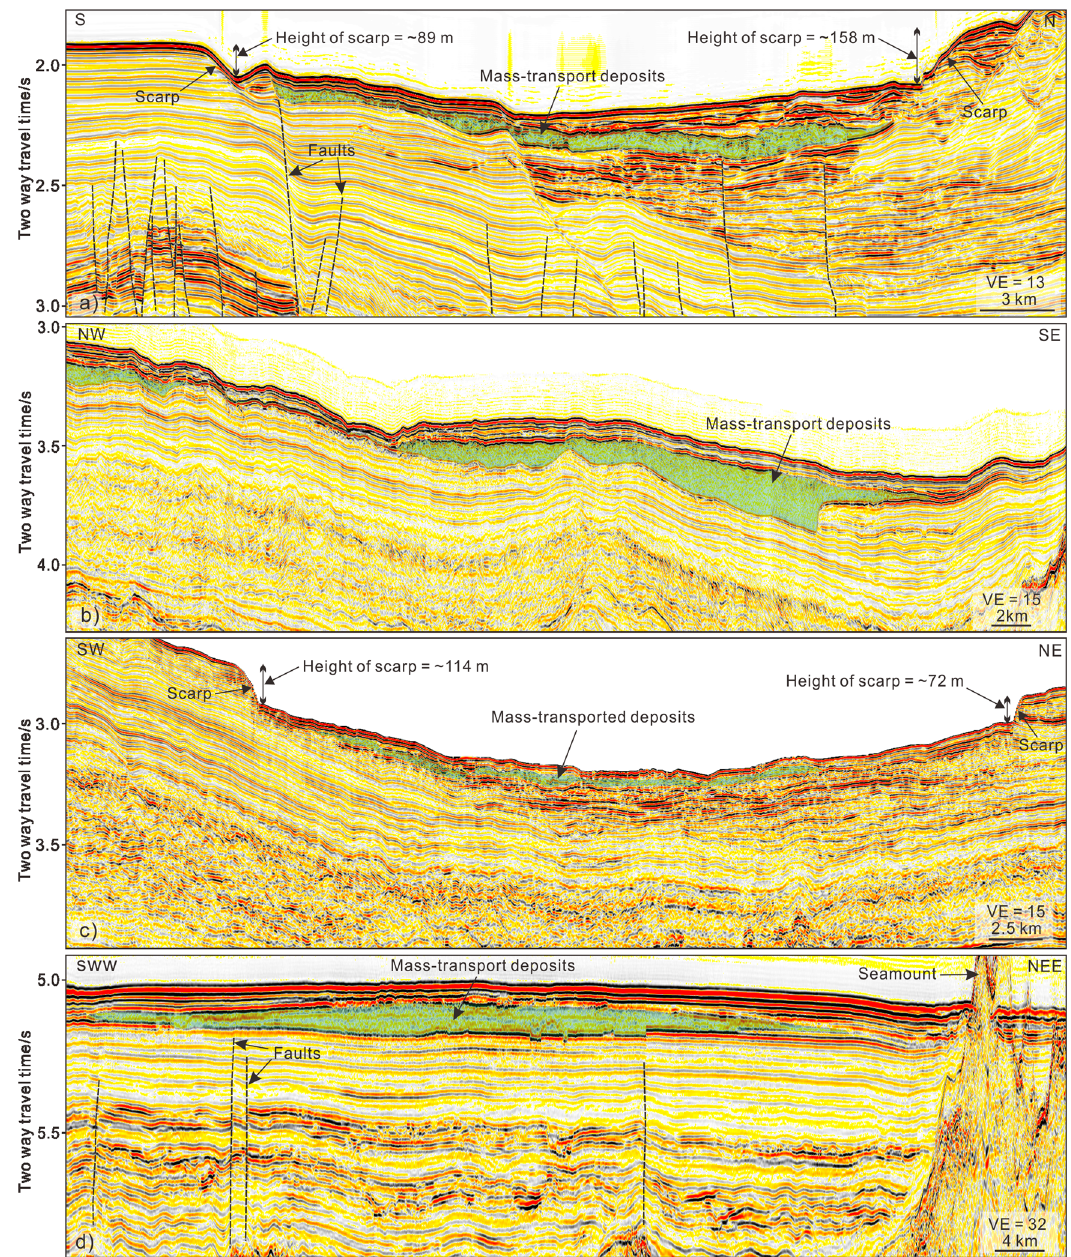
Fig. 3 Seismic character of mass-transport deposits. a – c Seismic character of mass-transport deposits on the continental slope. Failed strata show chaotic to transparent seismic re fl ections and internal deformation is not clearly imaged. Tall bounding scarps are also observed; d seismic character of failed strata in the ocean basin, which is similar to the character of failed strata in the slope basin. See the location of seismic pro fi les in Fig. 2b. VE vertical